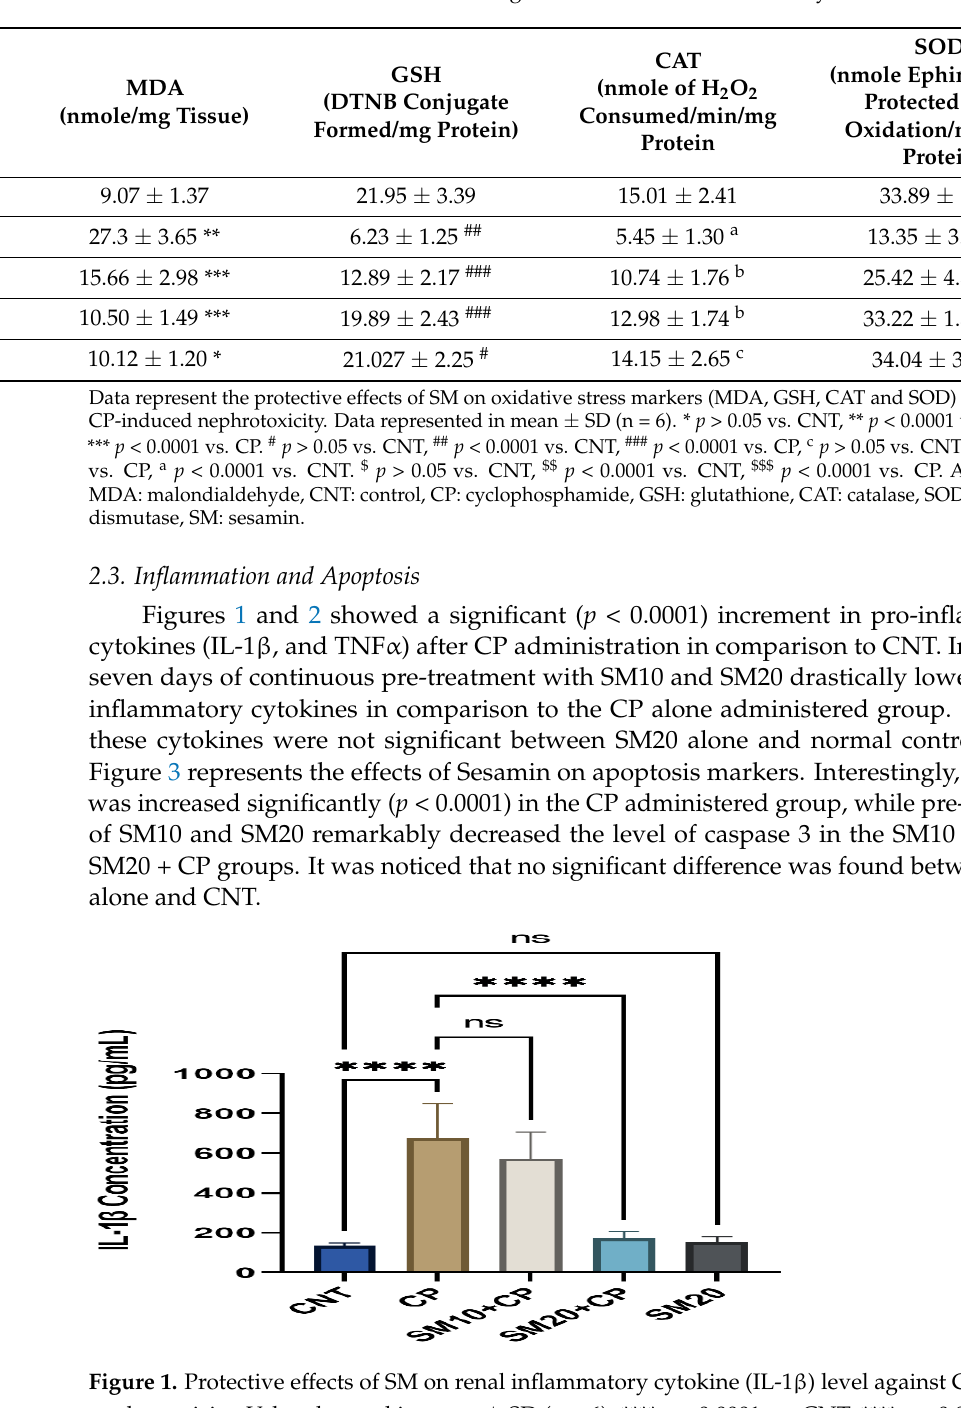
Table 2. Effects of SM on oxidative stress against CP-induced renal toxicity.